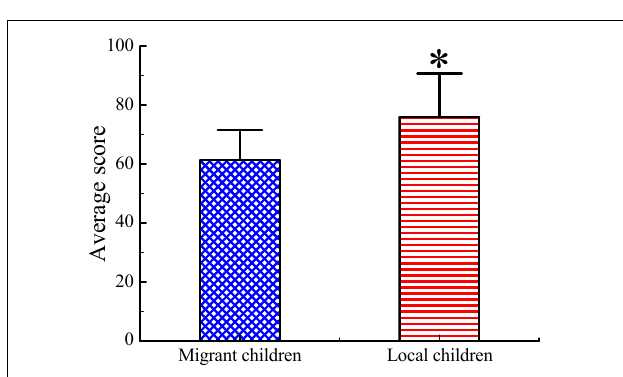
between text word vectors (Banerjee et al., 2019). The ALGCNN